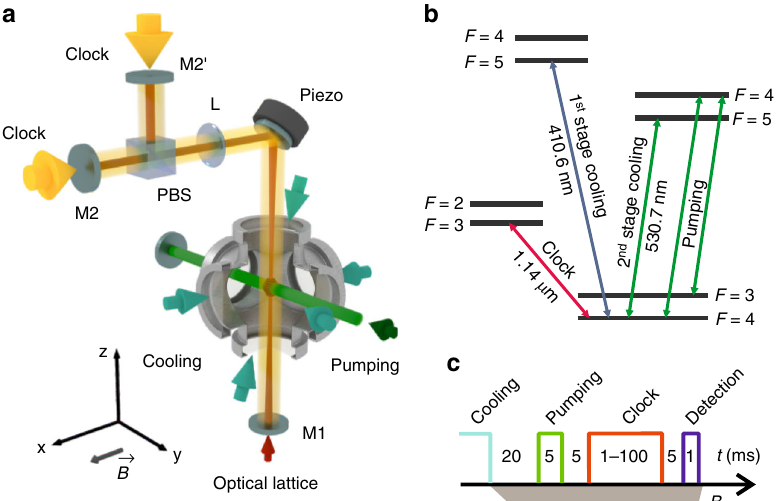
Fig. 1 Experimental details. a Schematic of the setup: the enhancement cavity forming the vertical optical lattice is built in a Γ -shape con fi guration with an intracavity polarizing beam splitter (PBS). For different polarizations, the two output couplers M2 and M2 ′ are used. The clock laser radiation at 1.14 μ m is fed collinearly with the cavity axis through one of the cavity outcouplers with corresponding polarization; the pumping and repumping laser beams form standing waves along the y -axis; and the initial position of the Tm magneto-optical trap is adjusted to the cavity waist. M1: cavity incoupler, L: lens. b Relevant Tm level scheme. c Pulse sequence for spectroscopy of the clock transition. Two-stage laser cooling is followed by pumping to the | F = 4, m = 0 〉 ground state using 530.7 nm radiation. The optical lattice is continuously on. After excitation of the clock transition, one measures the F fl uorescence of atoms remaining in the ground state by a 1 ms pulse (detection) at 410.6 nm (the same transition as for the fi rst-stage cooling). The bias magnetic fi eld B is denoted by a gray bar on the